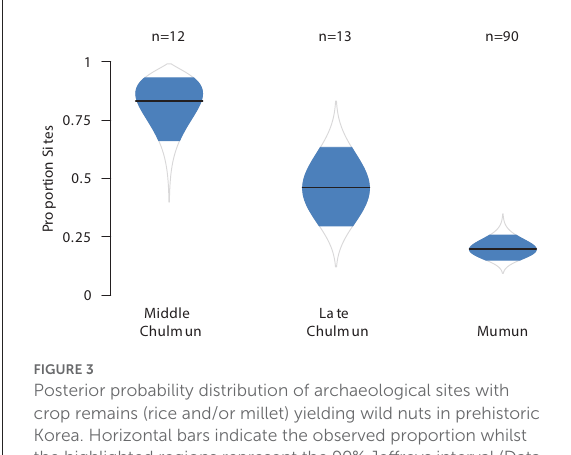
FIGURE3 Posterior probability distribution of archaeological sites with crop remains (rice and/or millet) yielding wild nuts in prehistoric Korea. Horizontal bars indicate the observed proportion whilst the highlighted regions represent the 90% Jeffreys interval (Data from National Research Institute of Cultural Heritage, 2015).